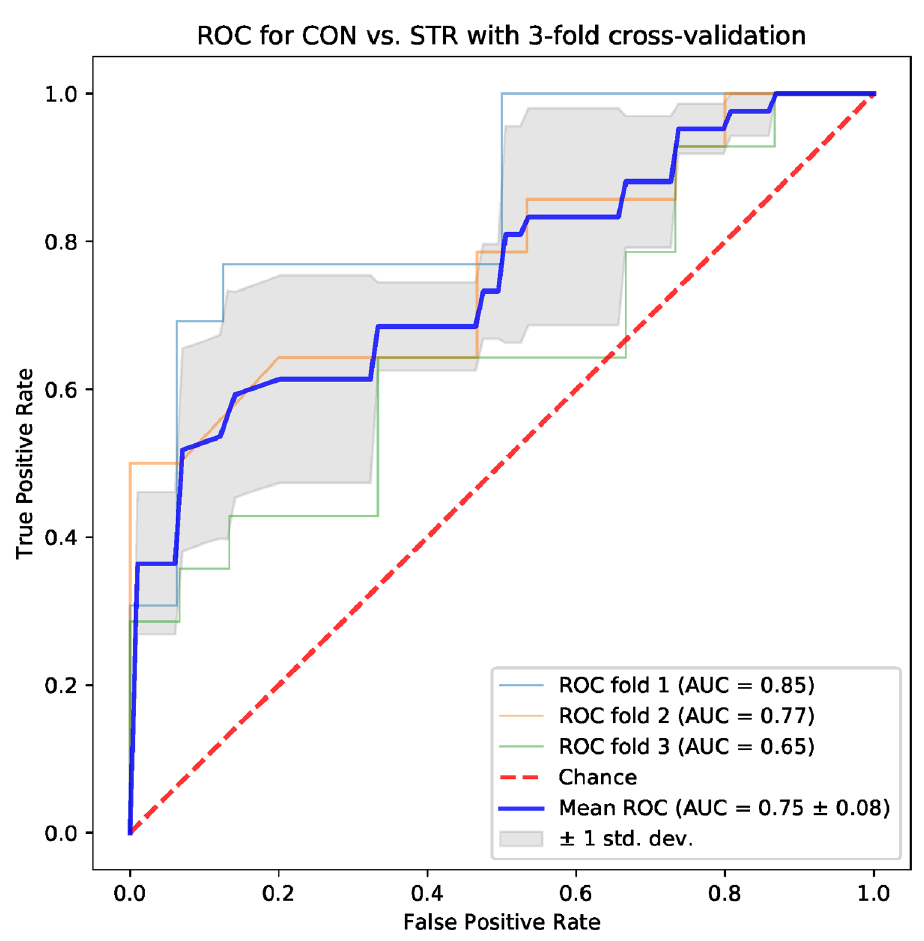
Fig 4. Results for the model trained with four frequency hrv parameters: Lf/hf ratio , lfnu , hfnu , total power .